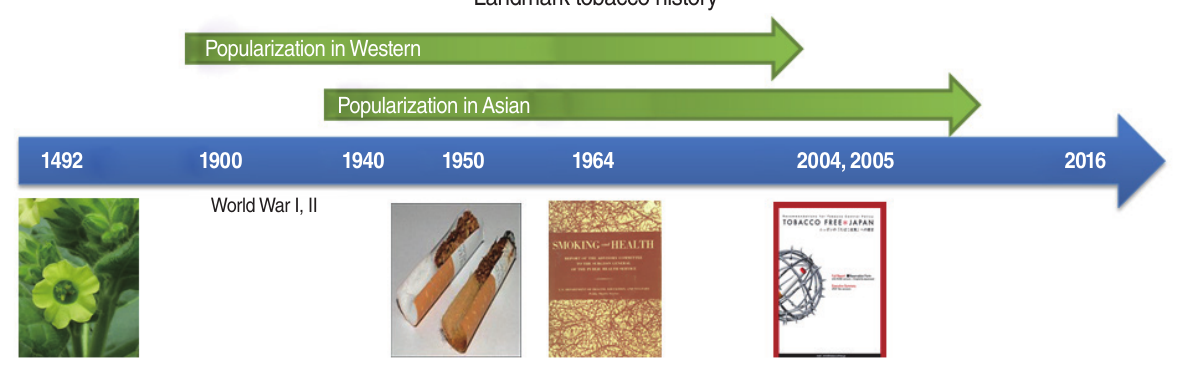
Figure 1. Landmarks of the history of tobacco, from discovery to popularization.